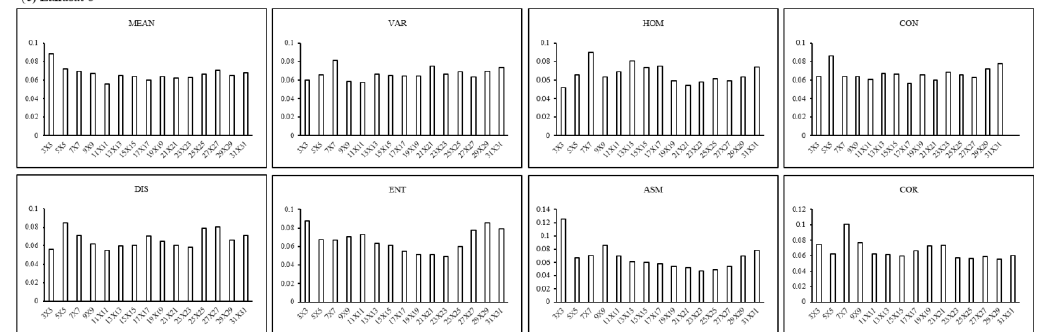
Figure 4. Feature importance at different window sizes of GF-1 ( a ), Sentinel-2 ( b ) and Landsat 8 ( c ). Vertical axis represents the value of feature importance.